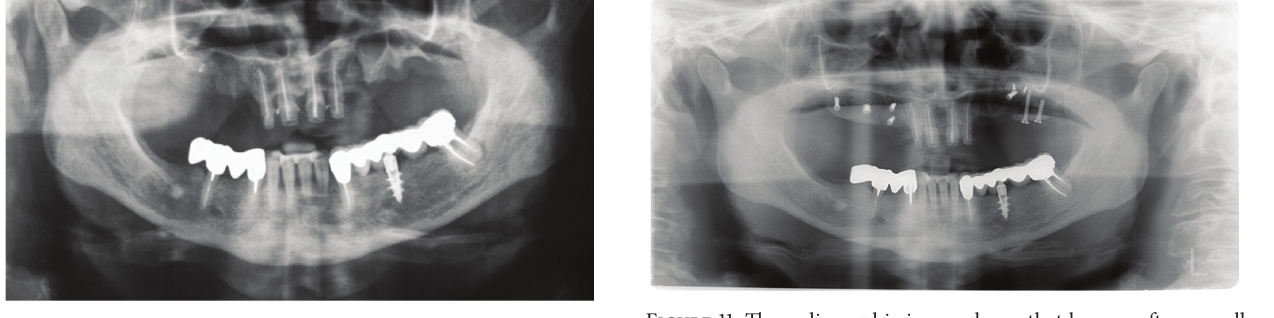
Figure 9: Case 2: initial OPT.